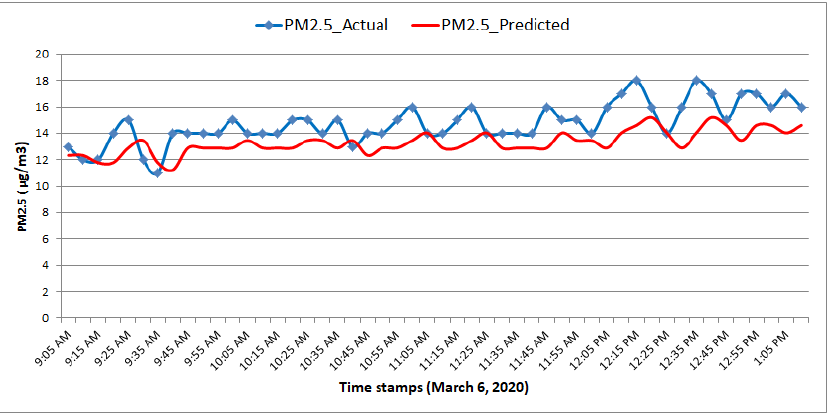
Figure 20. Predicted values of PM 2.5 after every 5 min vs. Actual values.